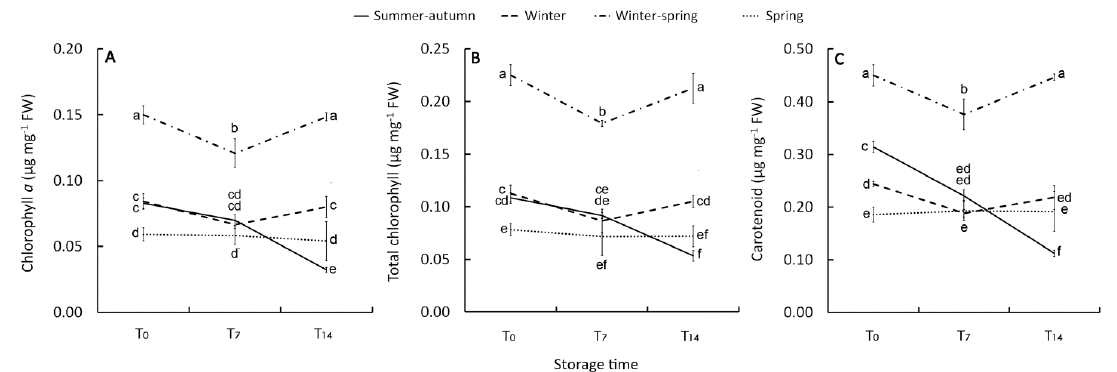
Figure 2. Effect of growing cycle on chlorophyll a ( A ), total chlorophyll ( B ), and carotenoids ( C ) concentration in the raw heads (T 0 ), 7 days (T 7 ) and 14 days (T 14 ) stored product. Vertical bars (± SE of mean) ( n = 9) with different letters are significantly different according to the Least Significant Difference test ( P = 0.05).